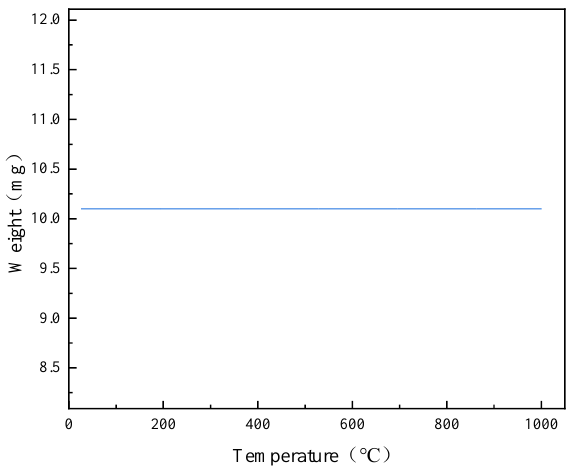
Figure 7. TGA curves of the NiFe 2 O 4.